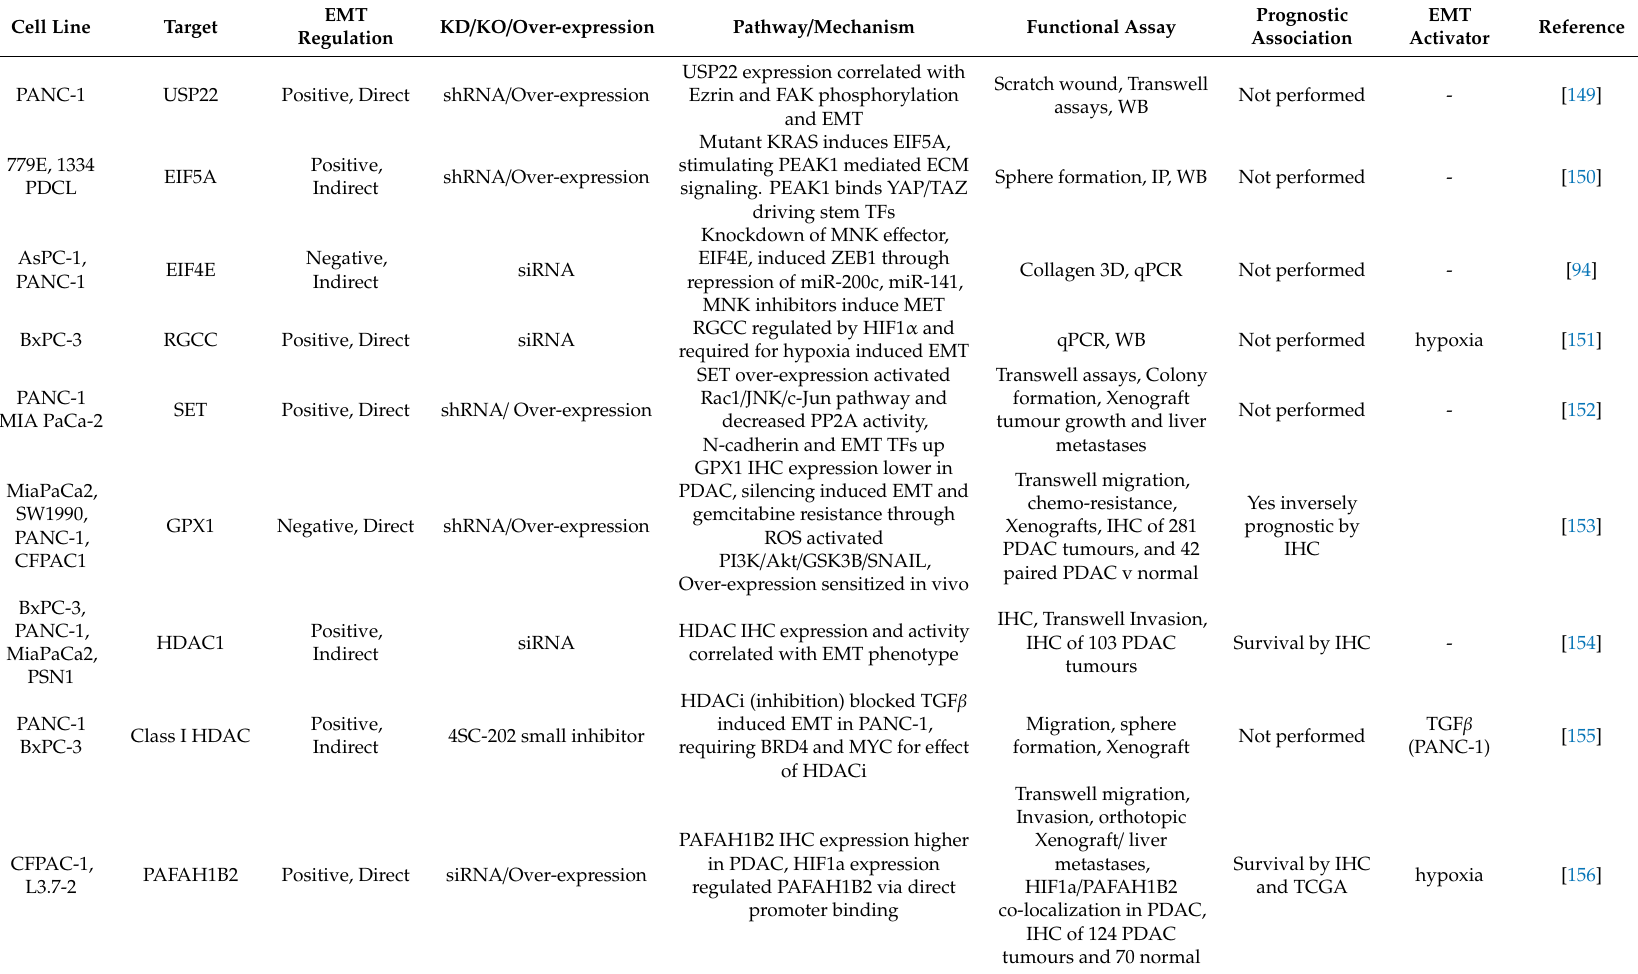
Table 6. Enzymes and Co-factors. This table describes intracellular proteins that may directly or indirectly participate in pathways required for EMP modulation by other enzymatic control of substrate proteins. Candidates that exhibit clinical correlation with lymph node metastasis are shown in